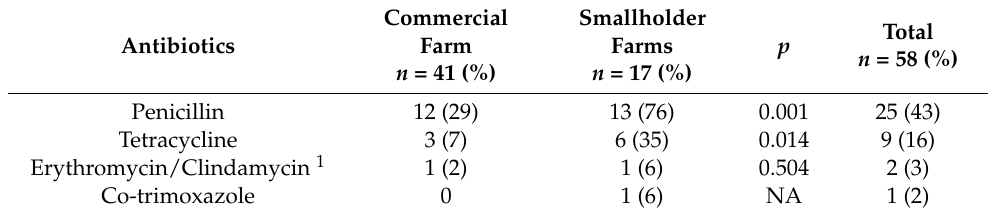
Table 1. Antibiotic resistance of Staphylococcus aureus isolated from raw milk samples of dairy cows in southern Mozambique between April and May